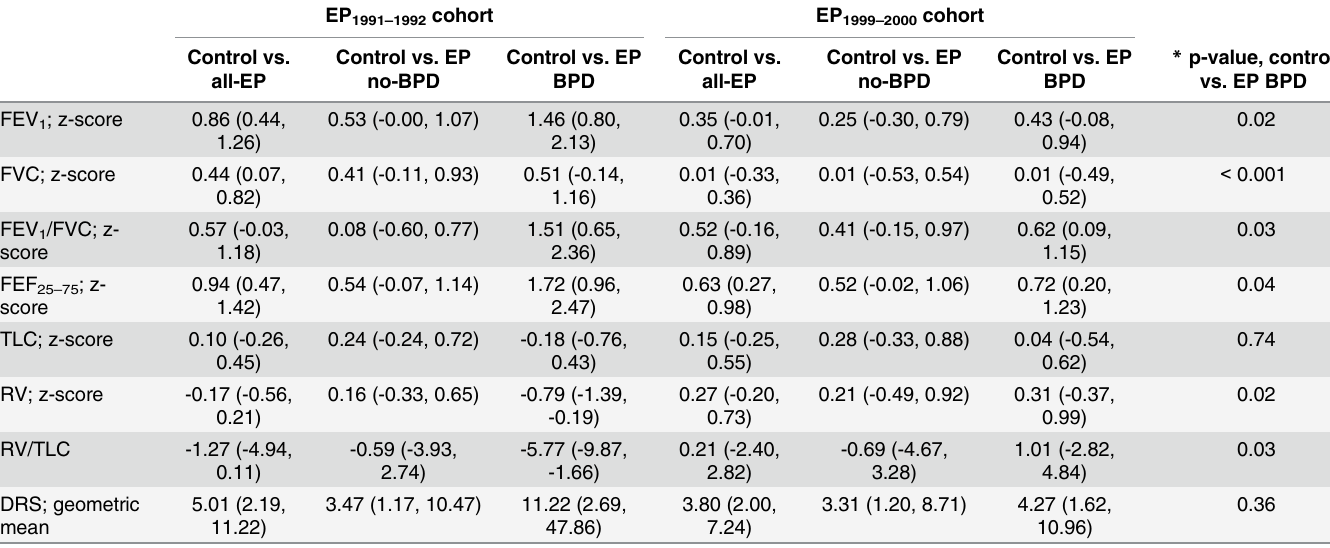
Table 5. Comparison of lung function indices in two cohorts of children born preterm in 1991 – 92 (EP 1991 – 92 ) and in 1999 – 2000 (EP 1999 – 2000